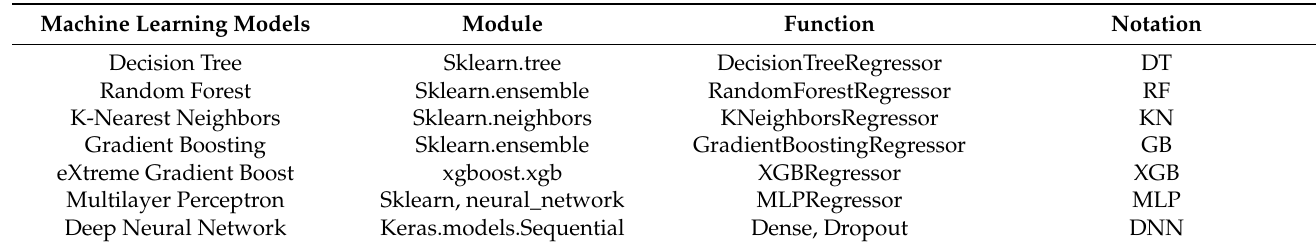
Table 1. Description of machine learning